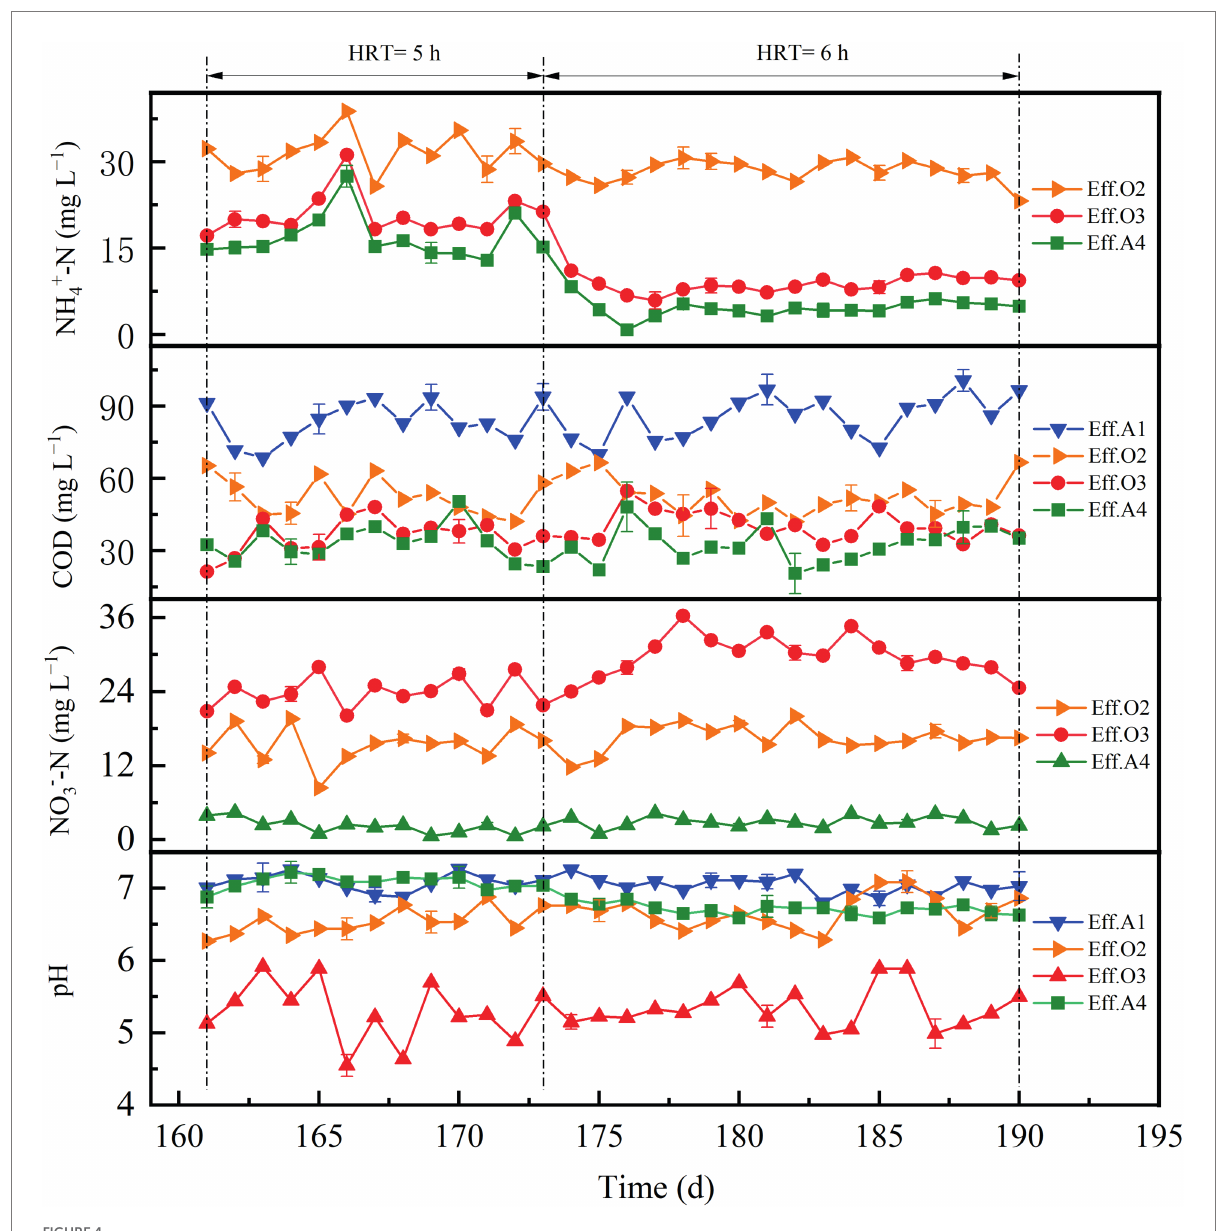
FIGURE 4 Performance of the reactor during period